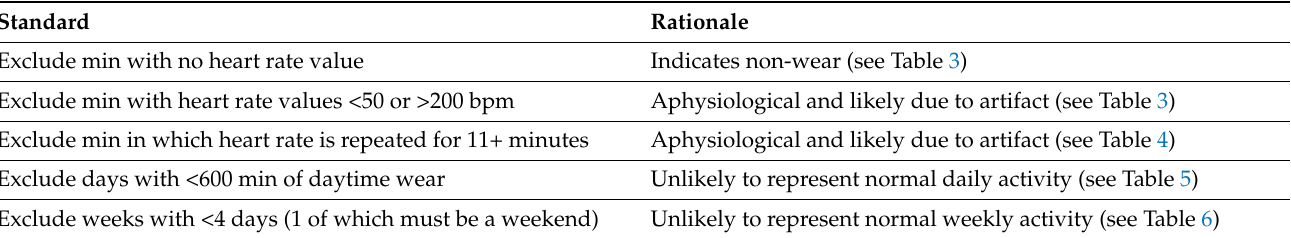
Table 7. Recommended best practice for evaluating Fitbit data to assess daily and weekly physical activity in